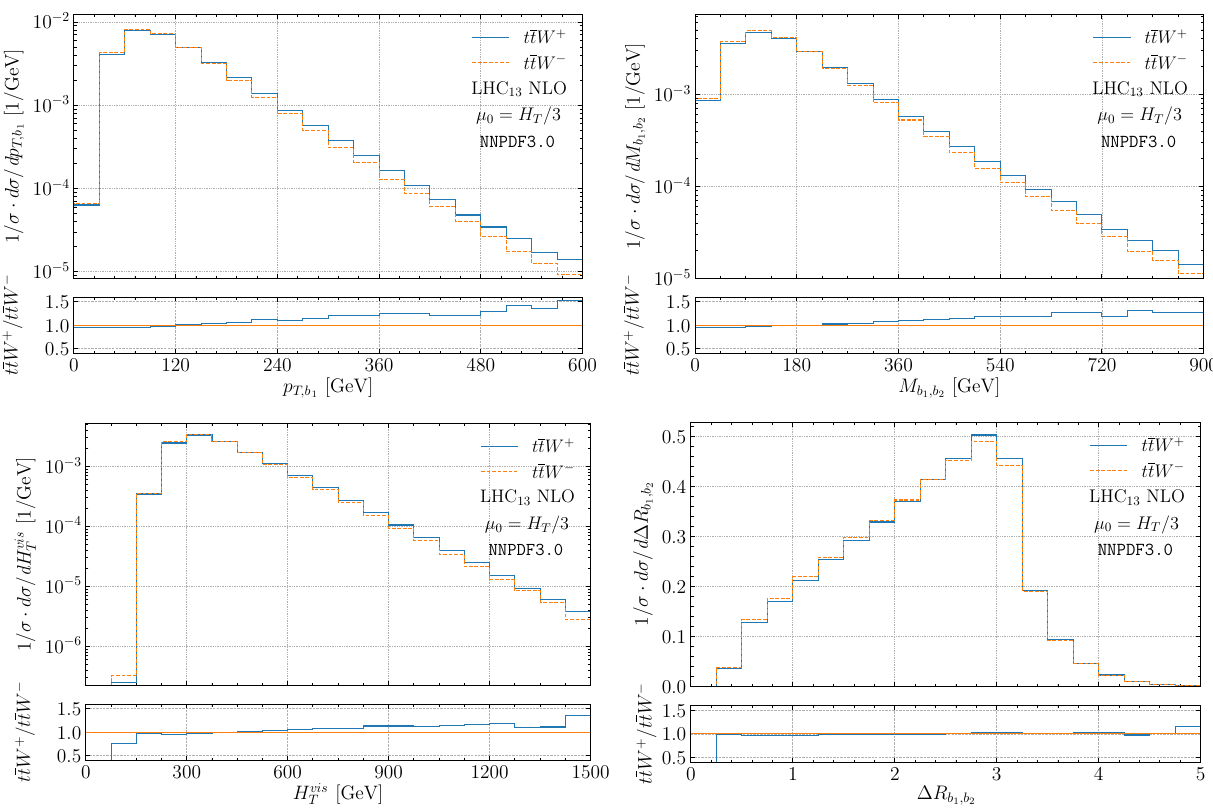
) , the invariant mass of the two b -jets ( M 1 ) and the distance in the azimuthal angle rapidity plane between the two b -jets ((cid:12) R T